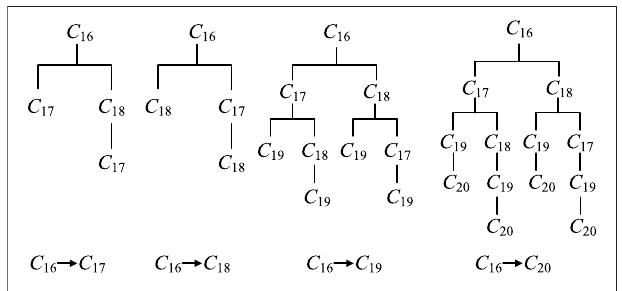
FIGURE 11 | Change propagation tree of C 16 in M 5